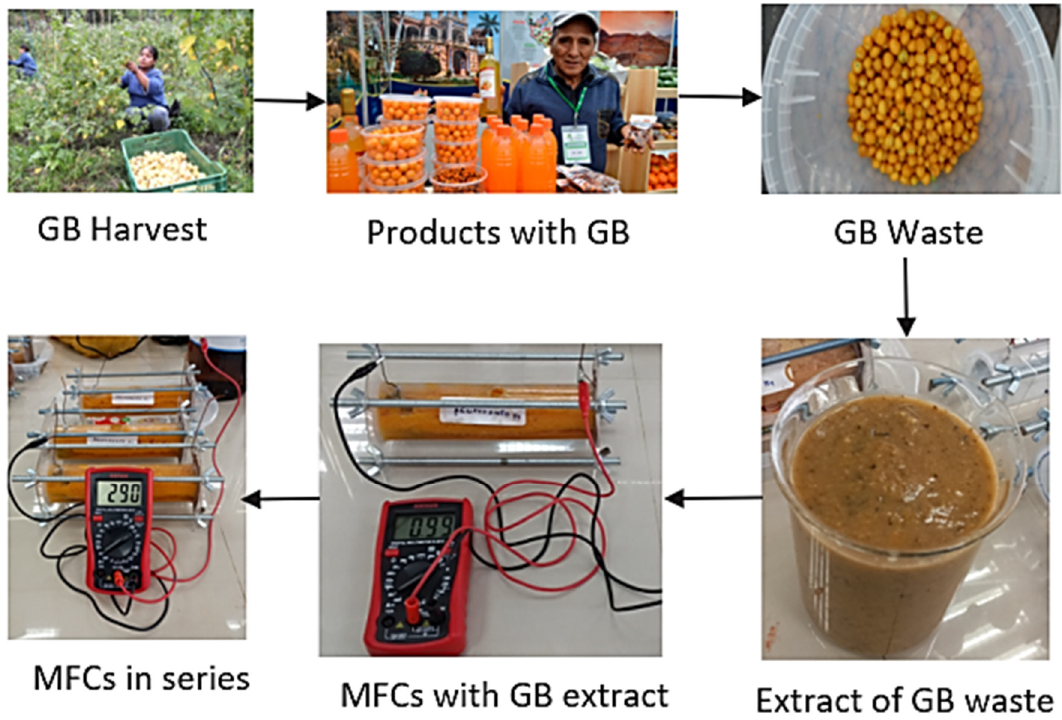
Figure 7. Scheme of bioelectricity production by using the three MFCs connected in series.